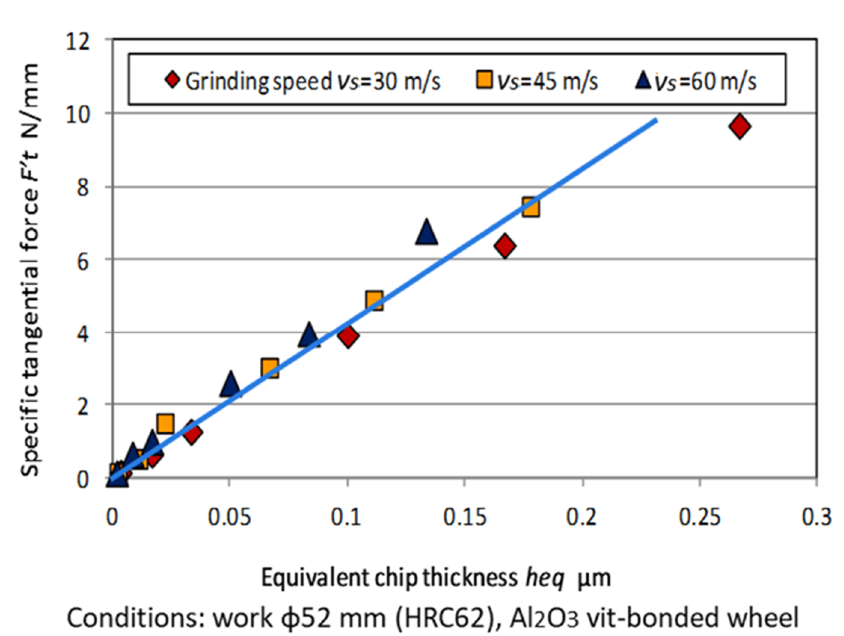
Figure 5. Equivalent chip thickness vs. grinding force in cylindrical grinding.